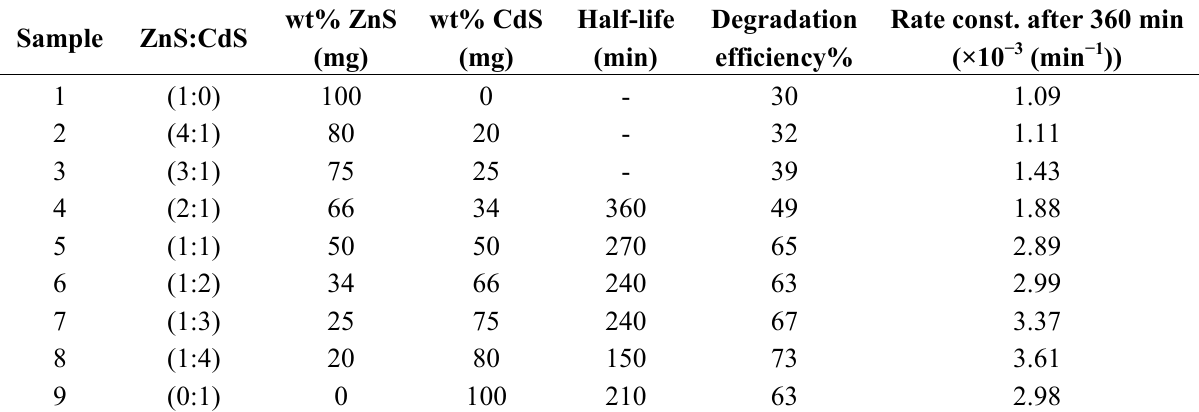
Table 2. Photodegradation data of MB in the presence of ZnS and CdS